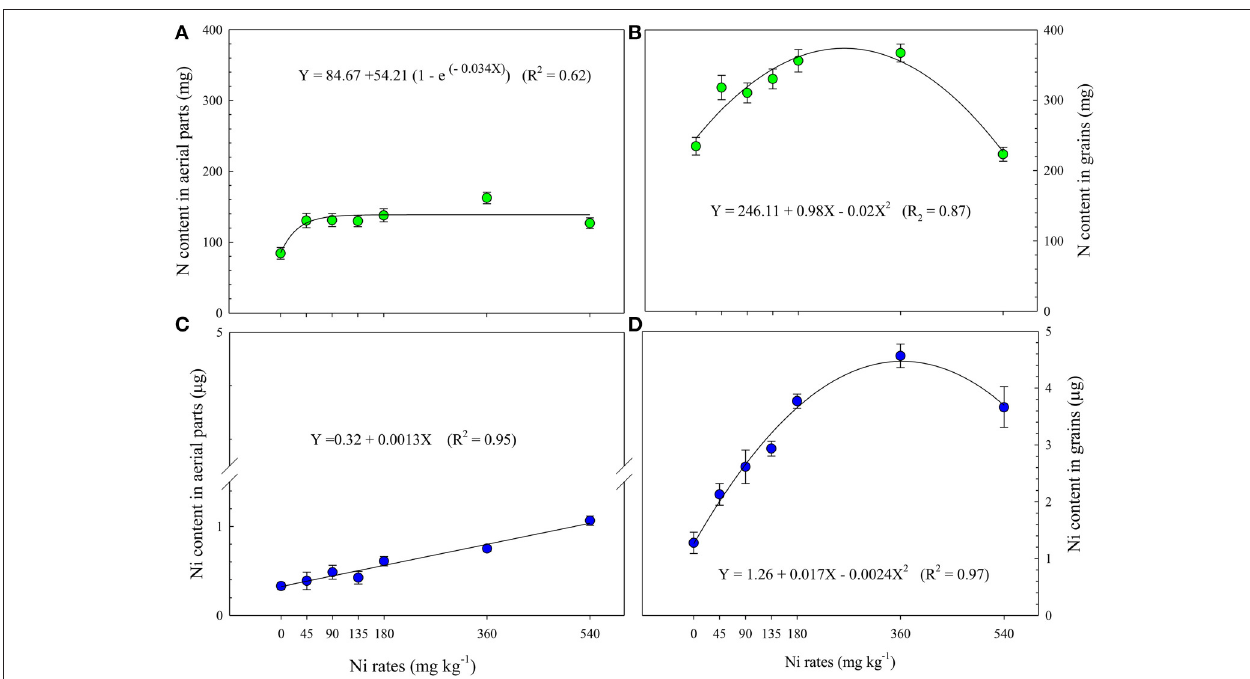
FIGURE 3 | Nitrogen content in the aerial parts (A) and in the grains (B) and nickel content in the aerial parts (C) and in the grains (D) of soybean cultivar BMX Potência RR , collected at R7 phenological stage (Fehr et al., 1971), as related to Ni seed treatments (rates). Four replicates per treatment. Mean ± SD. (Fisher Test, p < 0.01